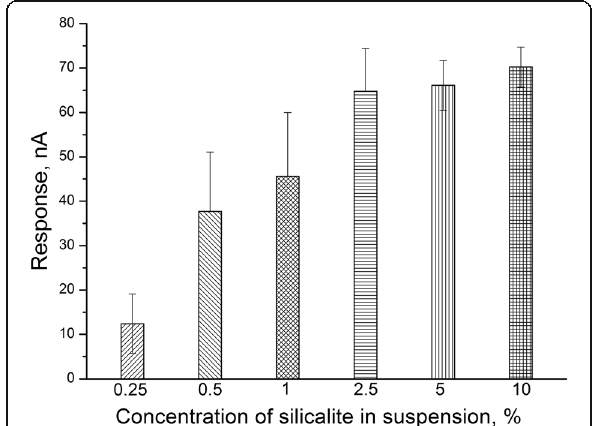
Fig. 5 Dependence of responses of biosensor based on GlOx, adsorbed on silicalite, on concentration of silicalite deposited on transducer during 90 s. Measurements in 20 mM HEPES buffer, pH 7.4, at a constant potential of +0.6 V vs Ag/AgCl reference